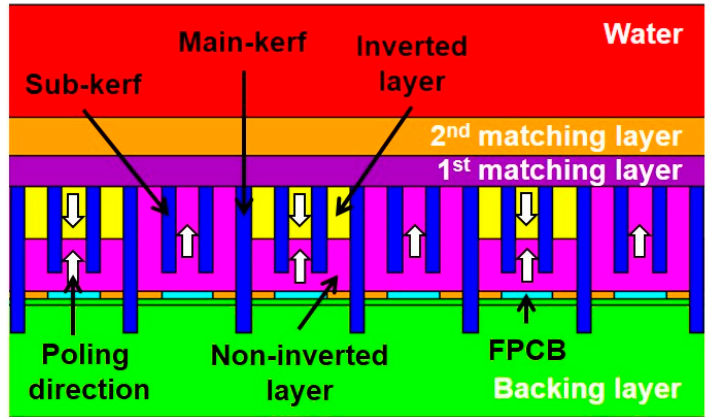
Figure 3. FEA-based schematic diagram of the proposed array transducer using the PIT for tissue harmonic imaging (THI). The array transducer was composed of the conventional elements for transmitting f 0 ultrasounds and the PIT elements for receiving reflected 2f 0 ultrasounds. The conventional elements exhibited the same poling direction, but the PIT elements exhibited the opposite poling direction. The identical matching layers were applied to the proposed model.